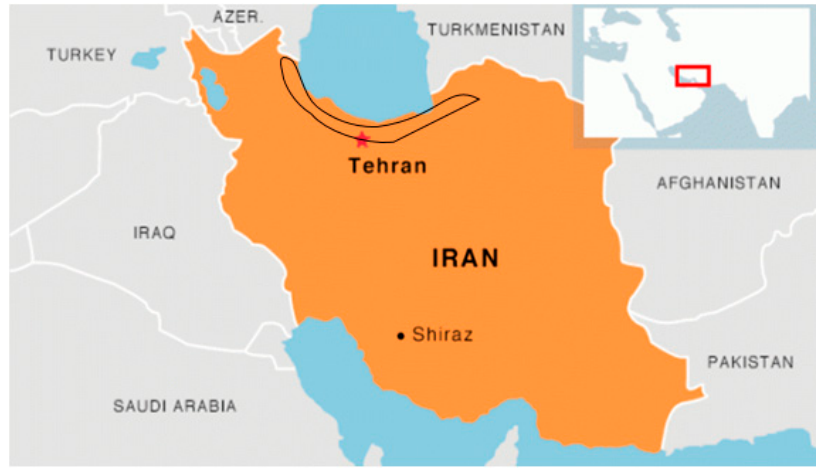
Figure 1. Geographic map (marked location) of sampling sites for M. aquatica plants from the Hyr- canian hotspot of Iran. Hyrcanian hotspot of